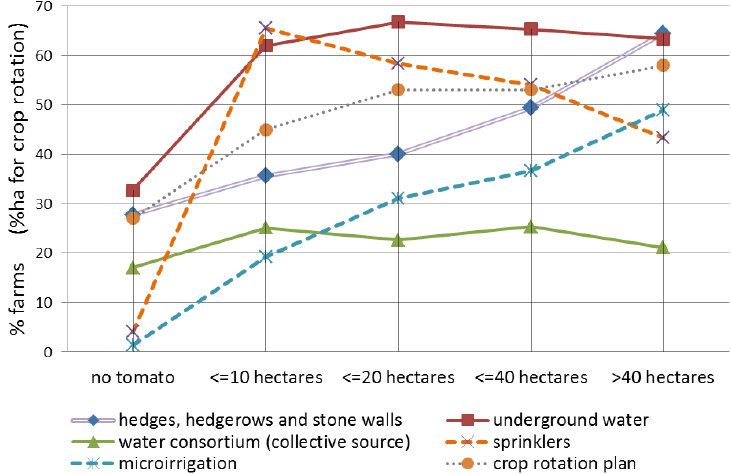
Figure 3. Key indicators of beneficial outcomes by tomato farm size in hectares. Source: our elaborations from Agricultural Census data (2010).